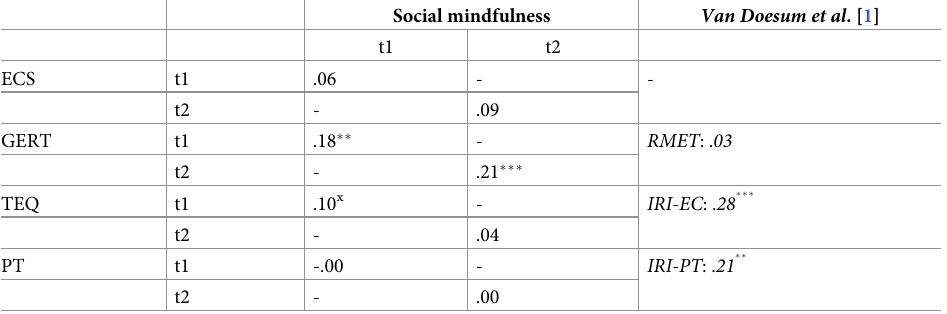
Table 2. Correlations between social mindfulness scores (First and second measurement occasions) and measures of empathy (First and second measurement occasions). Social